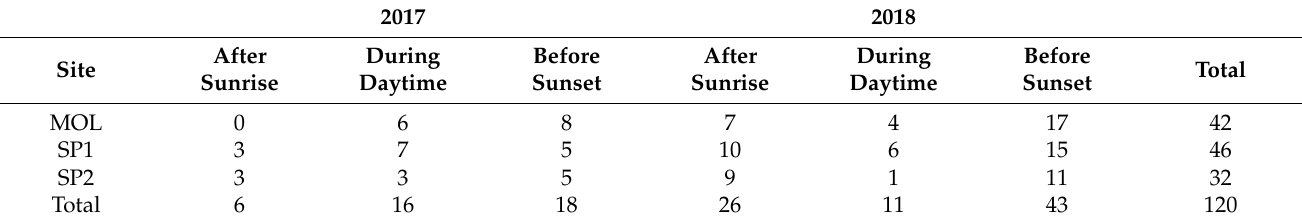
Table 2. Number of dives conducted during three time slots to directly observe the mottled grouper behaviours in the summers of 2017 and 2018 at the three study sites. Time slots: after sunrise (from 6:00 to 9:00), during the daytime (from 9:01 to 13:00) and before sunset (from 17:00 to 21:00). Hours refer to